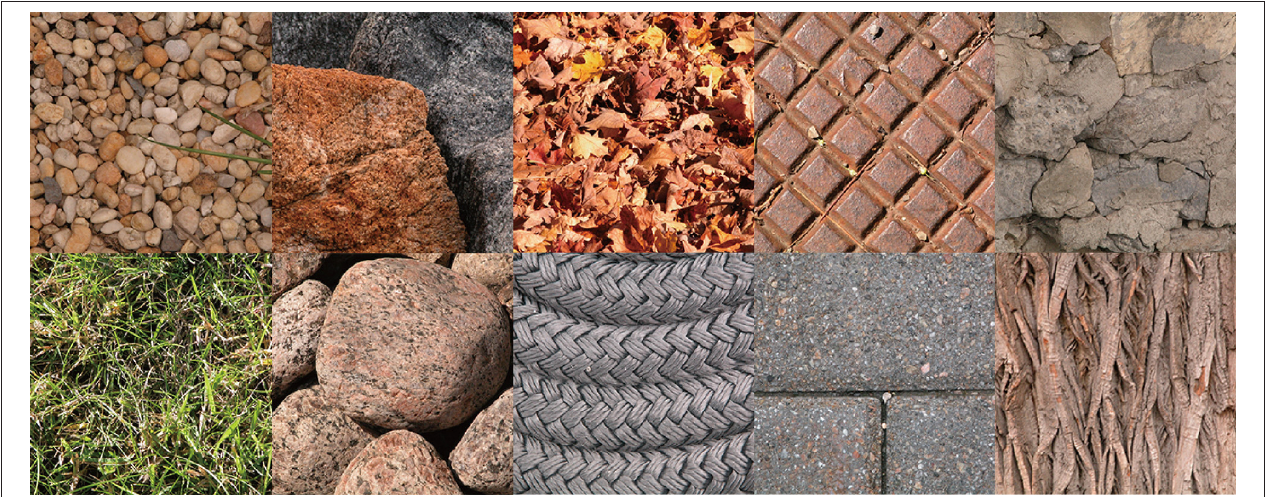
FIGURE 1 | Ten images used as background images in this